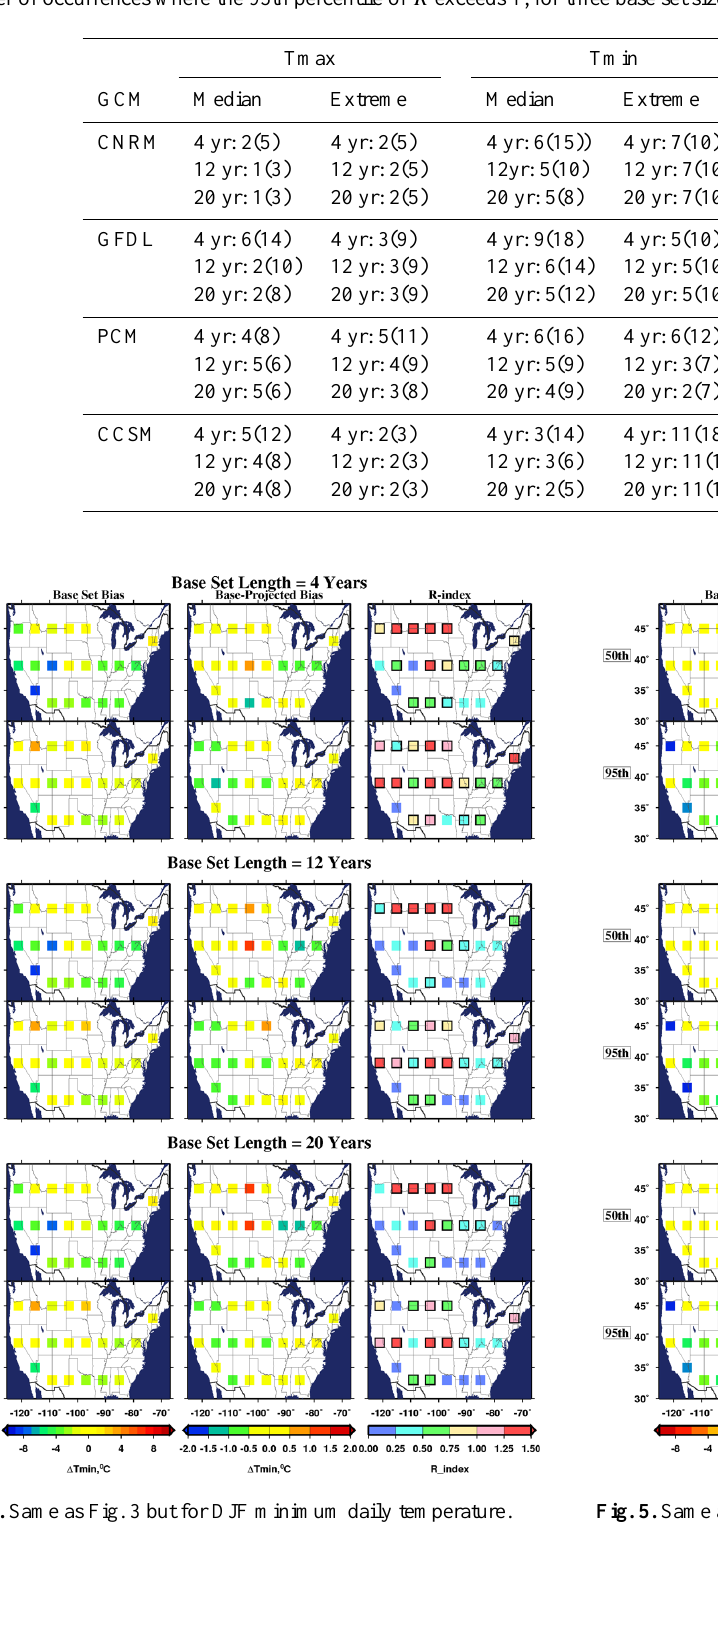
Table 2. Number of grid cells (out of the 20 in the domain) with mean (of 100 Monte Carlo simulations) R > 1 and, in parentheses, the number of occurrences where the 95th percentile of R exceeds 1, for three base set sizes and two percentiles.